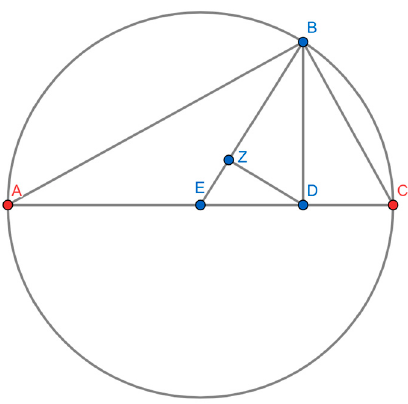
Figure 4. Pappus’ “Theory of Means”. Based on [38] (p. 569). Interval BZ, as side of triangle BZD, which is subcontrary to ABC, shows the role of subcontraraiety in the construction of the harmonic mean of AD and DC.